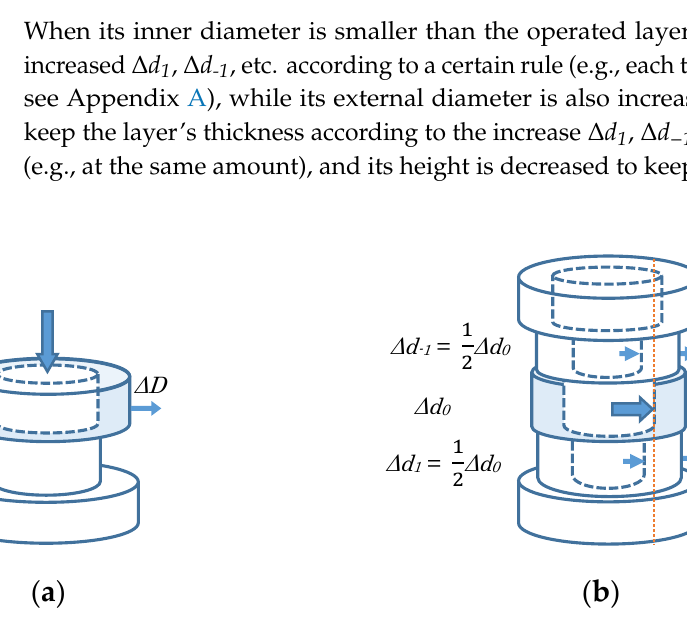
Figure 3. Forming the inner shape: ( a ) deepening the opening and ( b ) widening the